Question: Author a descriptive caption for the visualization shown.
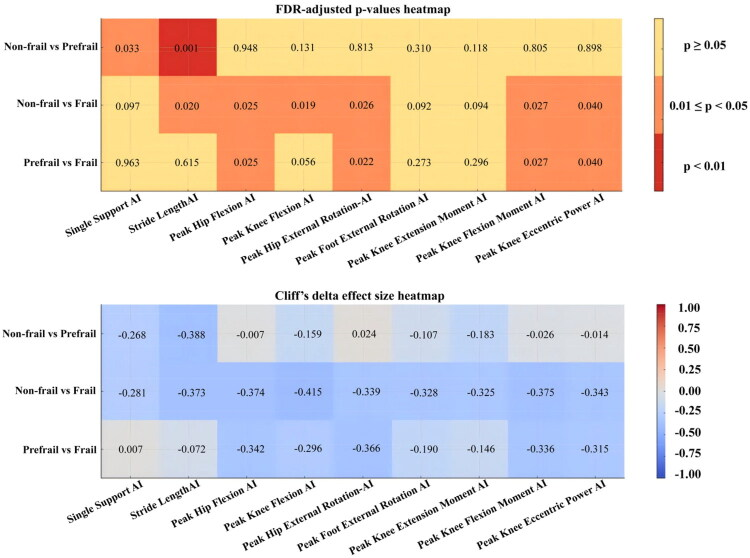
Answer: Vertical dual heatmap summarizing between-group differences in gait asymmetry indices. Note: The upper panel displays Benjamini–Hochberg FDR-adjusted p-values for the three pairwise comparisons (non-frail vs prefrail, non-frail vs frail, prefrail vs frail) using discrete threshold coloring. The lower panel shows the corresponding Cliff’s delta effect sizes on a continuous scale from −1 to +1, where positive values indicate greater asymmetry in the first group of each comparison and negative values indicate greater asymmetry in the second group; larger absolute values reflect larger between-group differences; AI: Asymmetry Index.